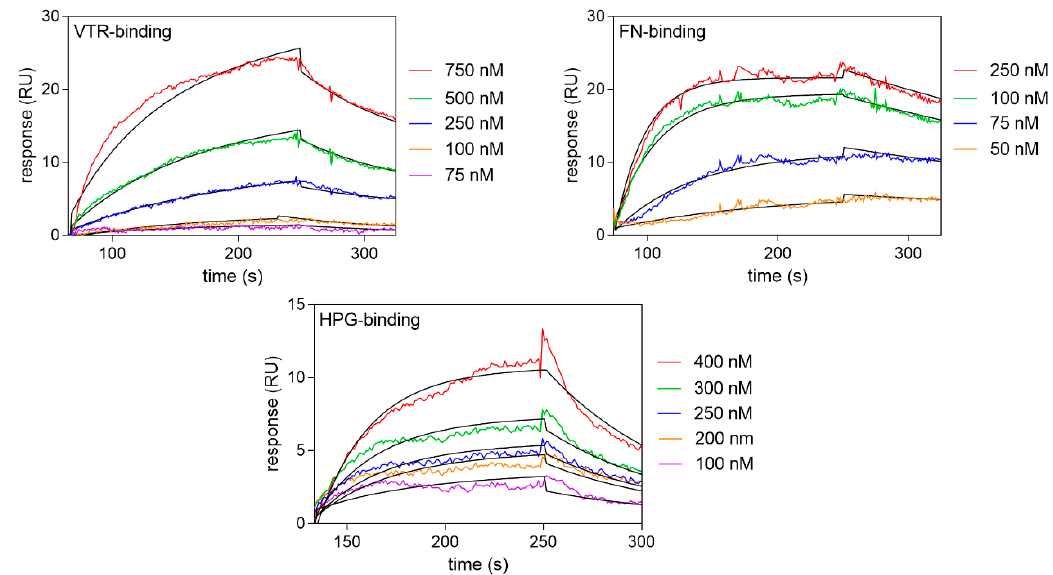
Figure 4. SPR analysis of the interactions between C. tropicalis enolase and VTR, FN and HPG. Sensograms were obtained after the injection of the human proteins (analyte concentrations were within a 75–750 nM range) over a CM5 chip containing immobilized enolase at a flow rate of 30 µL/min. A Langmuir 1:1 binding model with a baseline drift and Rmax locally was well fitted to the sensograms, as shown by the black lines. These data were collected from three independent experiments.